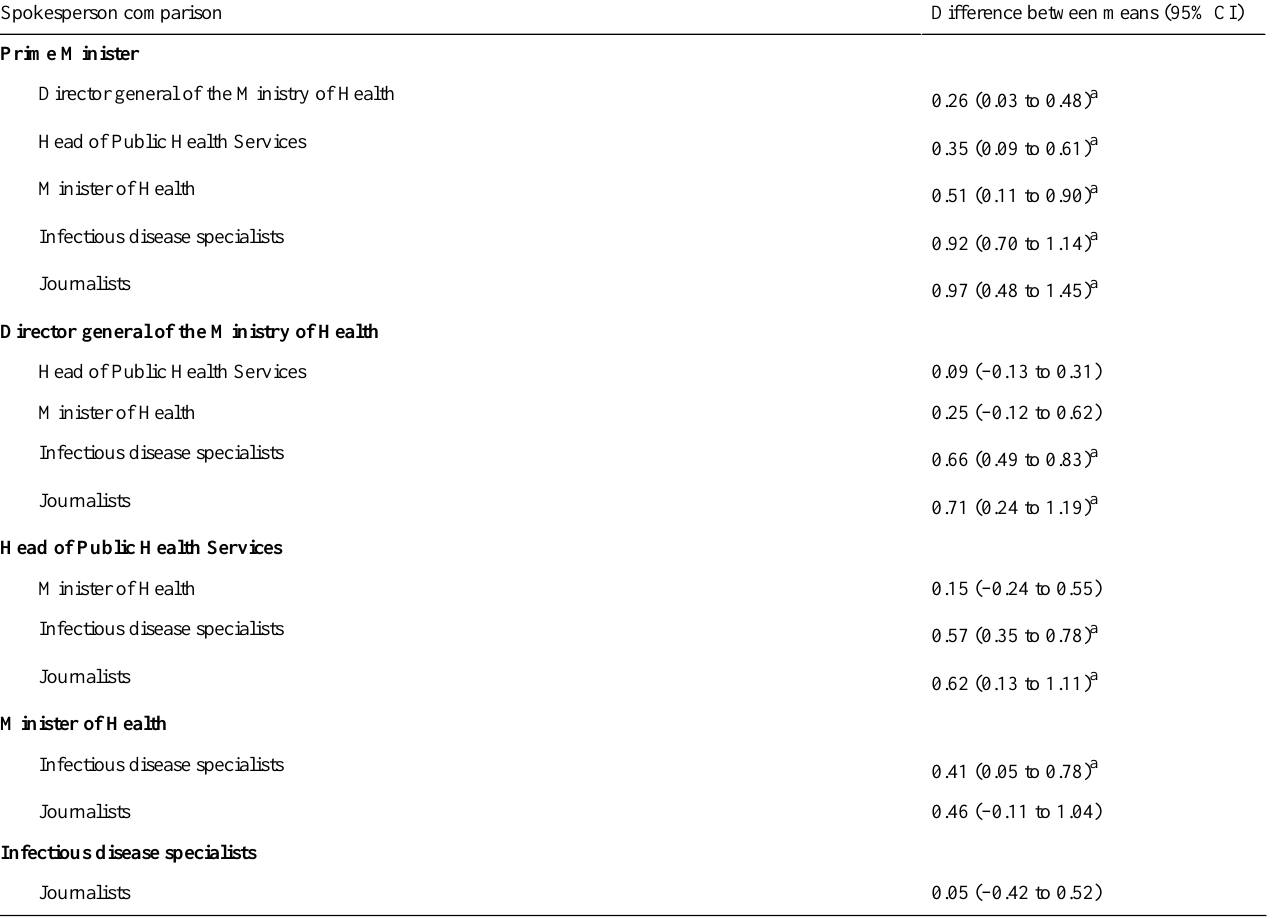
Table 5. Results of the Tukey HSD test for differences between the most credible spokesperson and the attitudes toward crisis management (n=987).